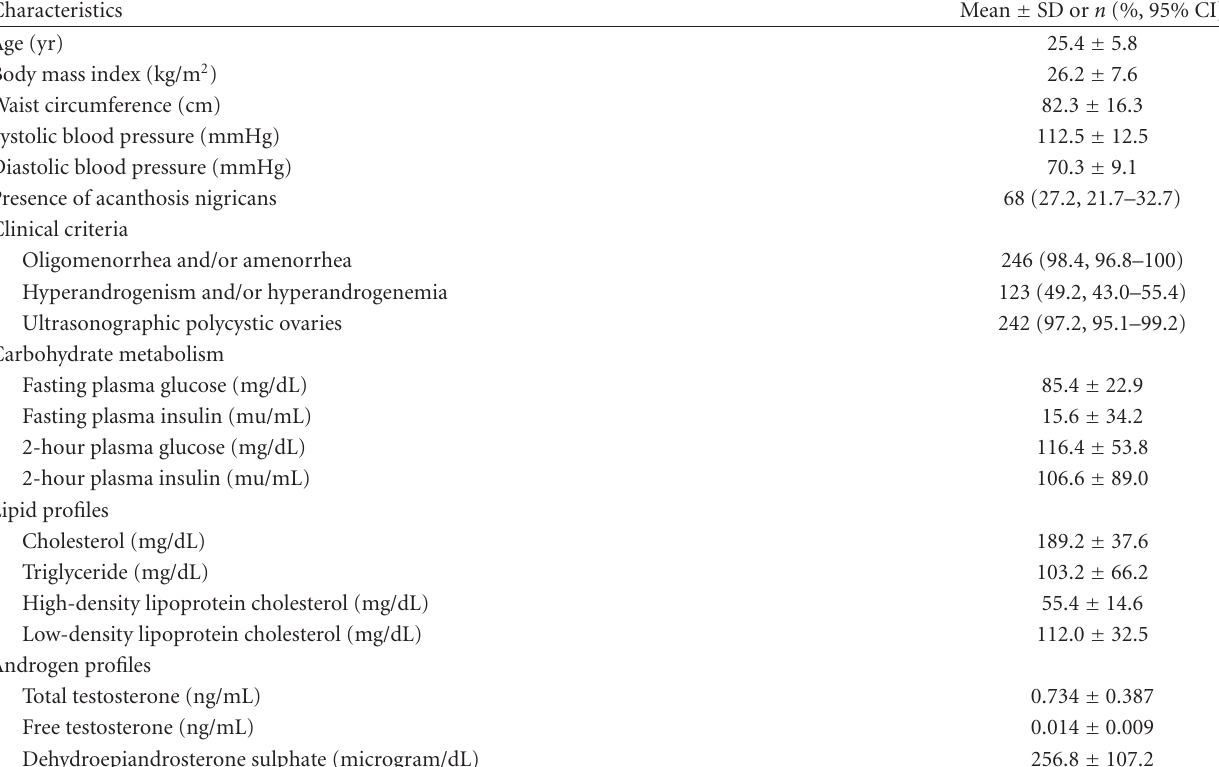
Table 1: Characteristics of 250 Thai women with polycystic ovary syndrome.